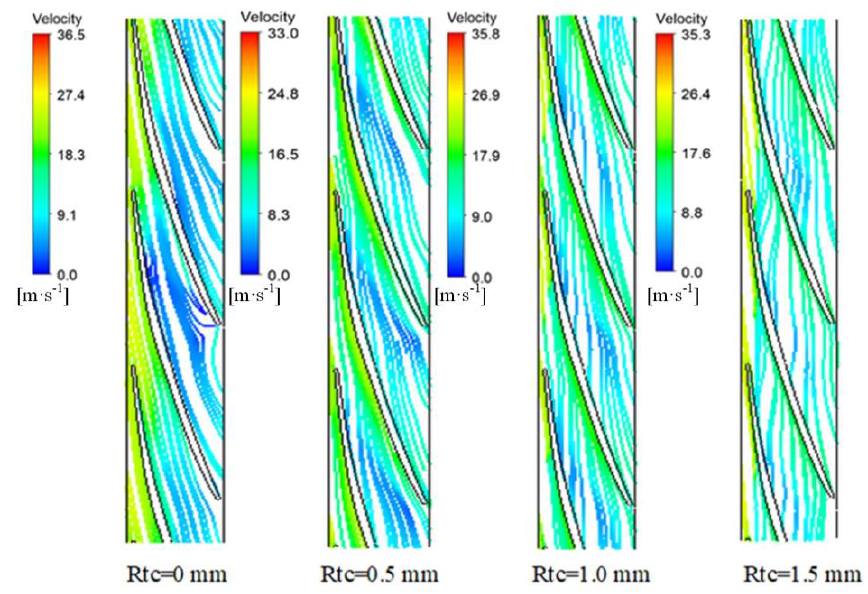
Figure 12. Streamlines at the radial coefficient r * = 0.9.